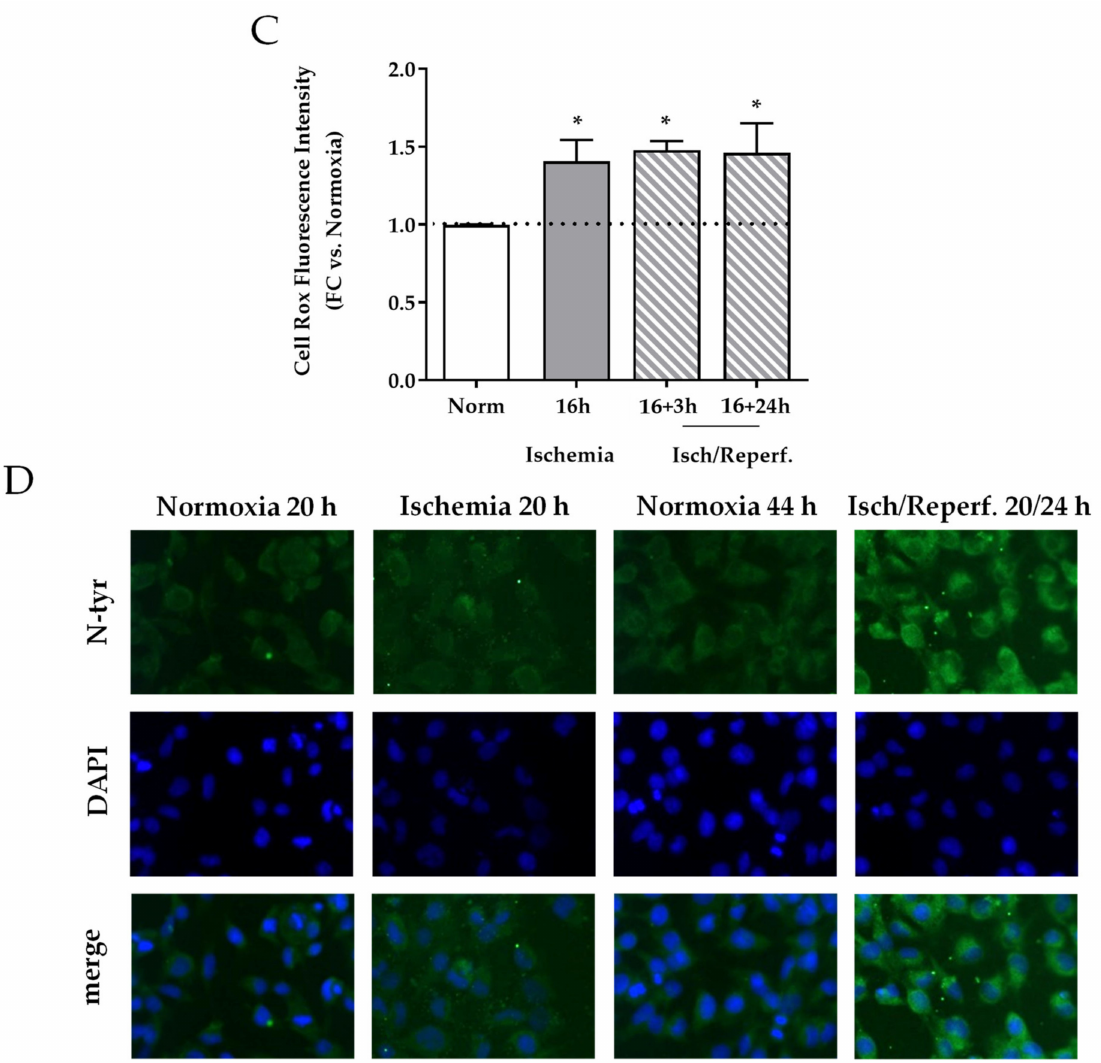
Figure 4. Cell cycle distribution and oxidative stress during I/R in HK-2 tubular renal cells. Flow cytometry analysis of cell cycle phases determined after ( A ) 20 h of ischemia and ( B ) 24 h of reperfusion using the Triton/propidium iodide solution; * p < 0.05. ( C ) Quantification of cell ROS production after 16 h of ischemia and 3–24 h of reperfusion using the CellROX™ kit; * p < 0.05. ( D ) Immunofluorescence for N-tyr, green signal (Alexa